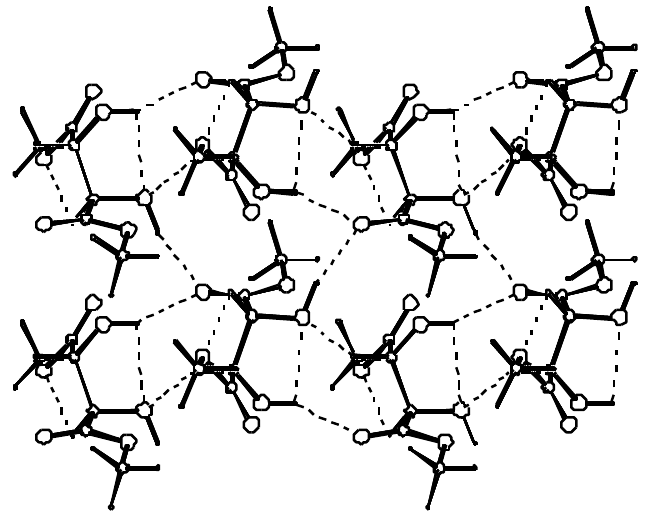
Figure 3. A layer formed by hydrogen-bonded molecules. Each molecule uses two of its hydroxyl groups to form hydrogen bonds with only one of its two carbonyl oxygens. The second carbonyl oxygen acts as an acceptor in a weak C-H...O